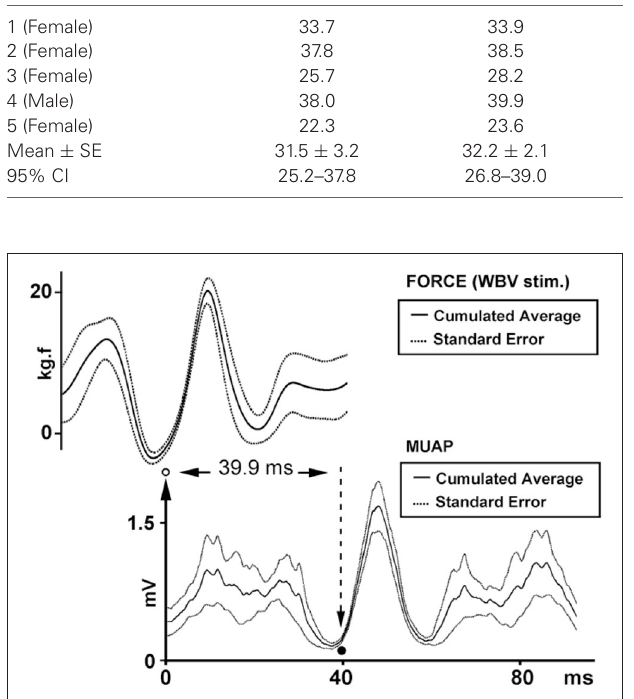
FIGURE 3 | Reflex latency measurement using cumulated average method. The arrow and open circle shows the position of the effective stimulus point (the lowest value of the SE of force trace). Solid circle shows the onset of EMG response (the lowest value of the SE of MMU